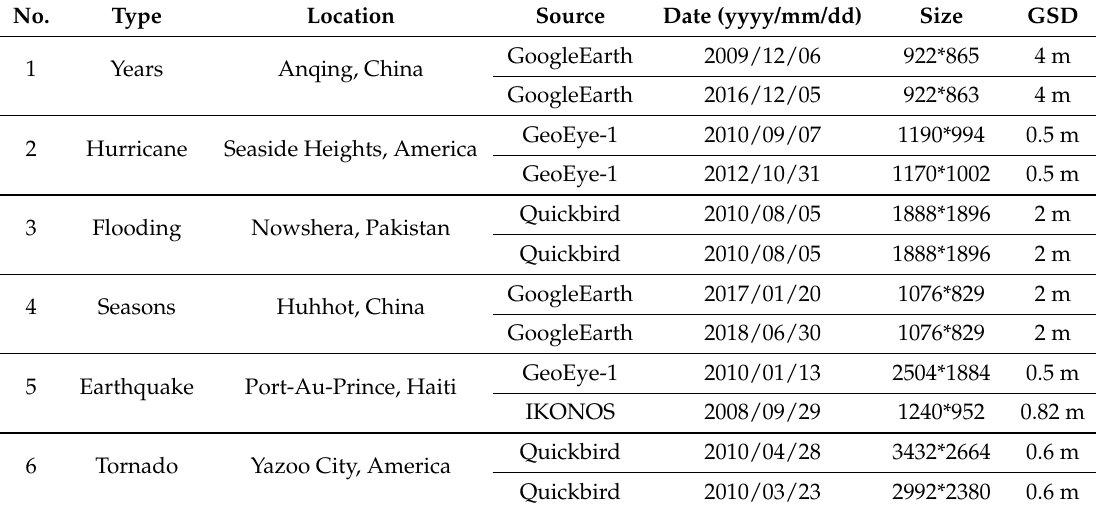
Table 4. Datasets of real remote sensing images.